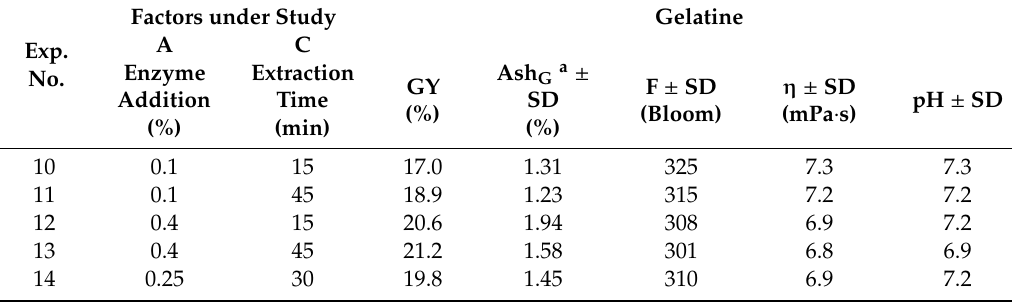
Table 3. The experimental design and the results of processing of chicken feet into gelatines (process optimization).